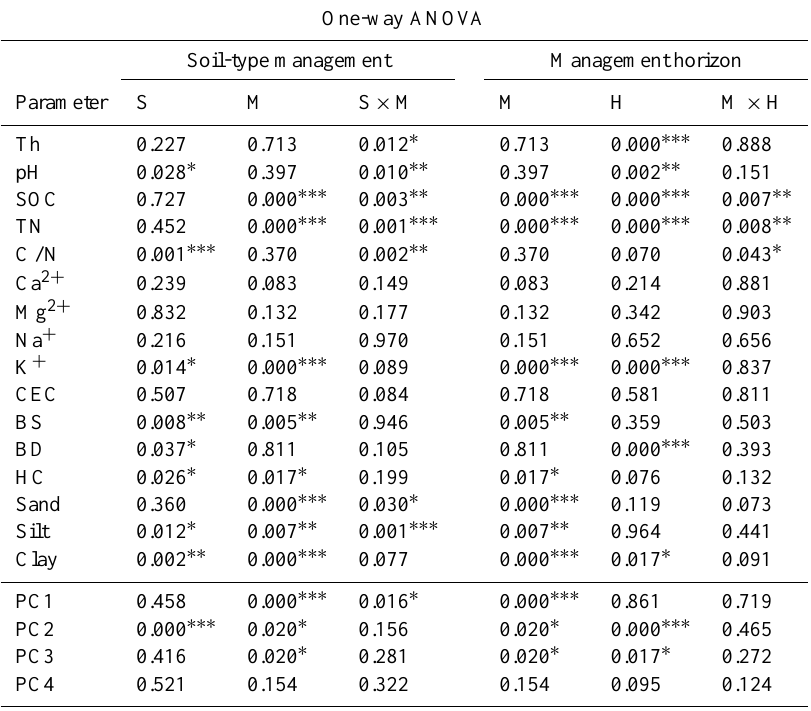
Table 6. General lineal model (GLM). ANOVA (soil type and management) for soil. Statistical analyses of soil were carried out for A horizon samples ( r